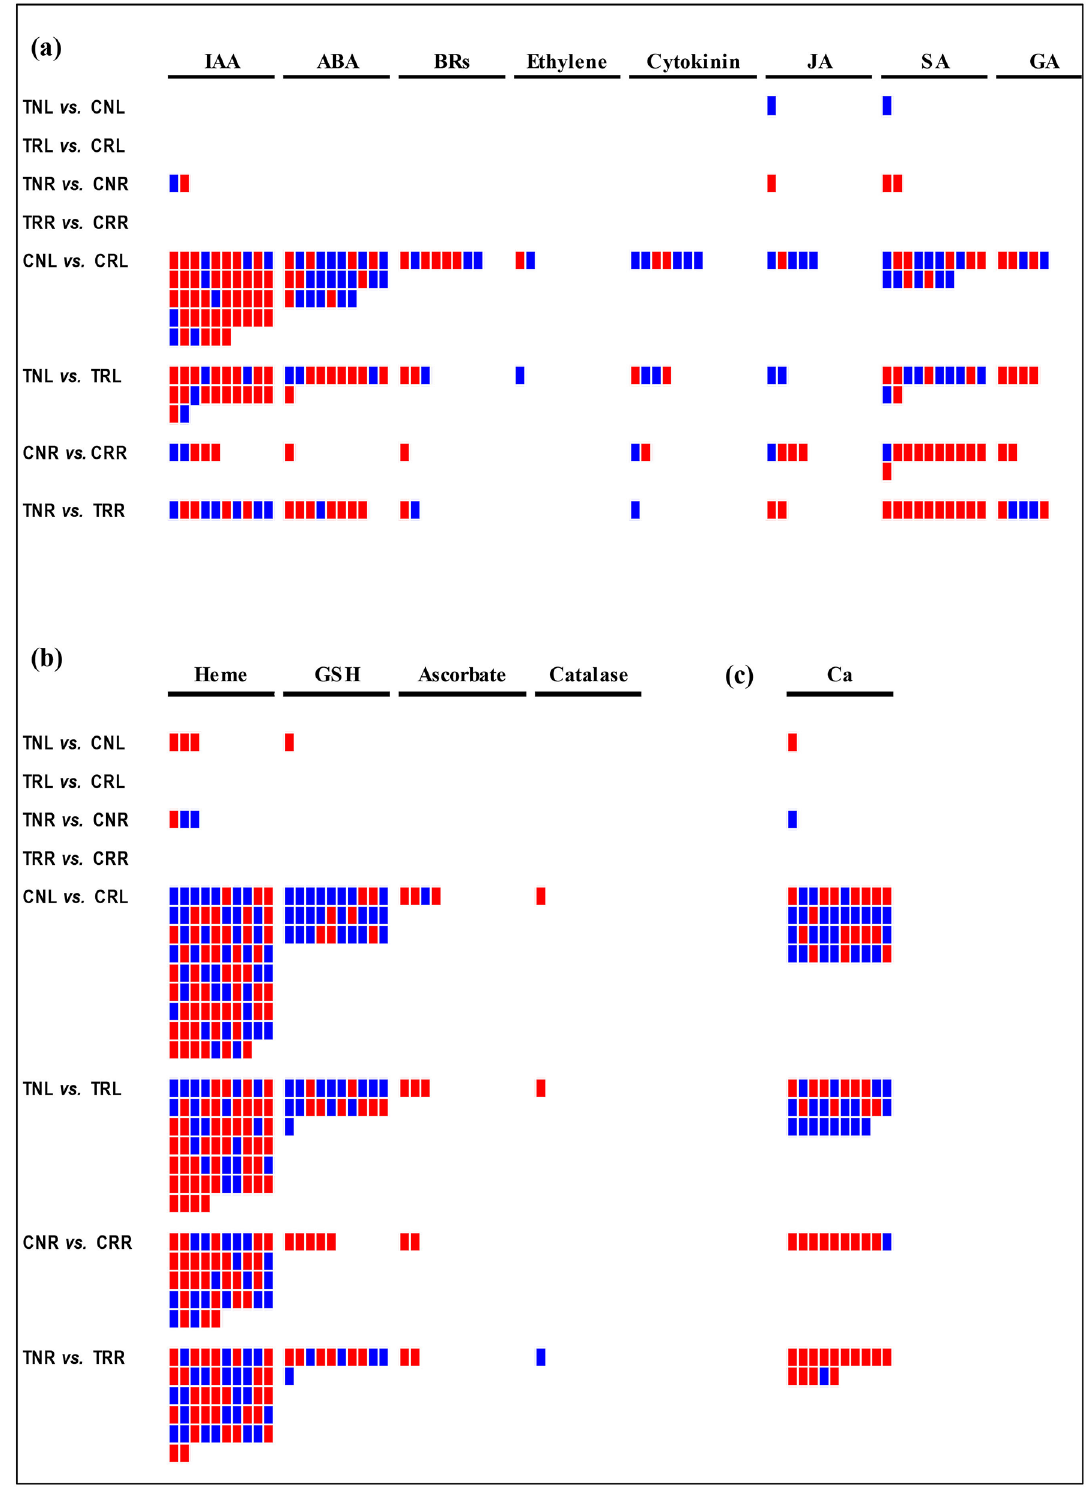
Figure 4. DEGs associated with phytohormone, redox, and calcium signaling pathways. ( a ) DEGs associated with phytohormone pathways (are indicated at the top). ( b ) DEGs associated with redox signaling pathways (are indicated at the top). ( c ) DEGs associated with calcium signaling (Ca). The red color indicates downregulated DEGs, and the blue color indicates upregulated DEGs. Left-side texts show pairwise comparisons. The top four compared samples indicate treatment versus control, and the bottom for compared samples indicate salt-sensitive versus salt-tolerant comparisons. IAA , indole acetic acid (auxin); ABA , abscisic acid; BRs , brassinosteroids; JA , jasmonic acid; SA , salicylic acid; GA, gibberellins; GSH , glutathione; Ca ,